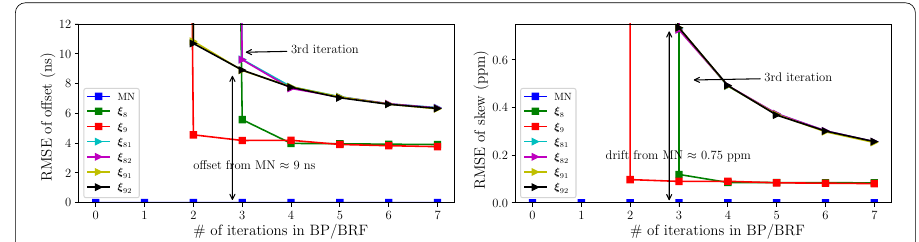
Fig. 10 BP and BRF applied to the network in a hybrid